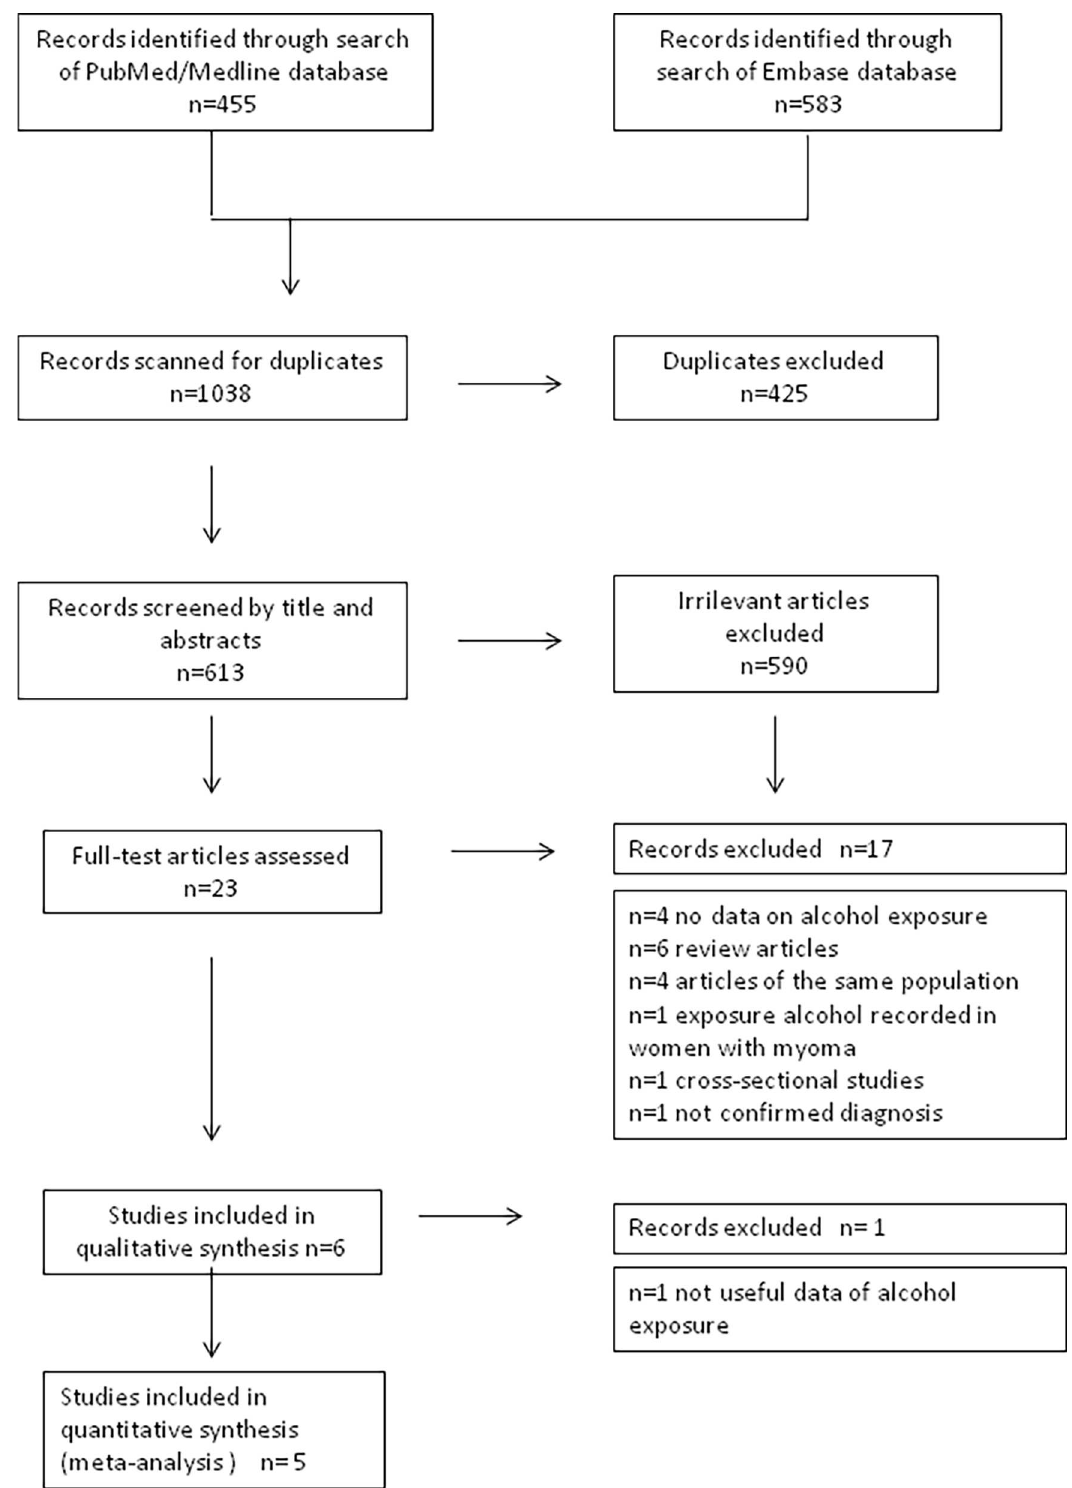
Fig 1. Flow chart of the selection of studies on alcohol intake and risk of uterine myoma included in the systematicreview and meta-analysis.